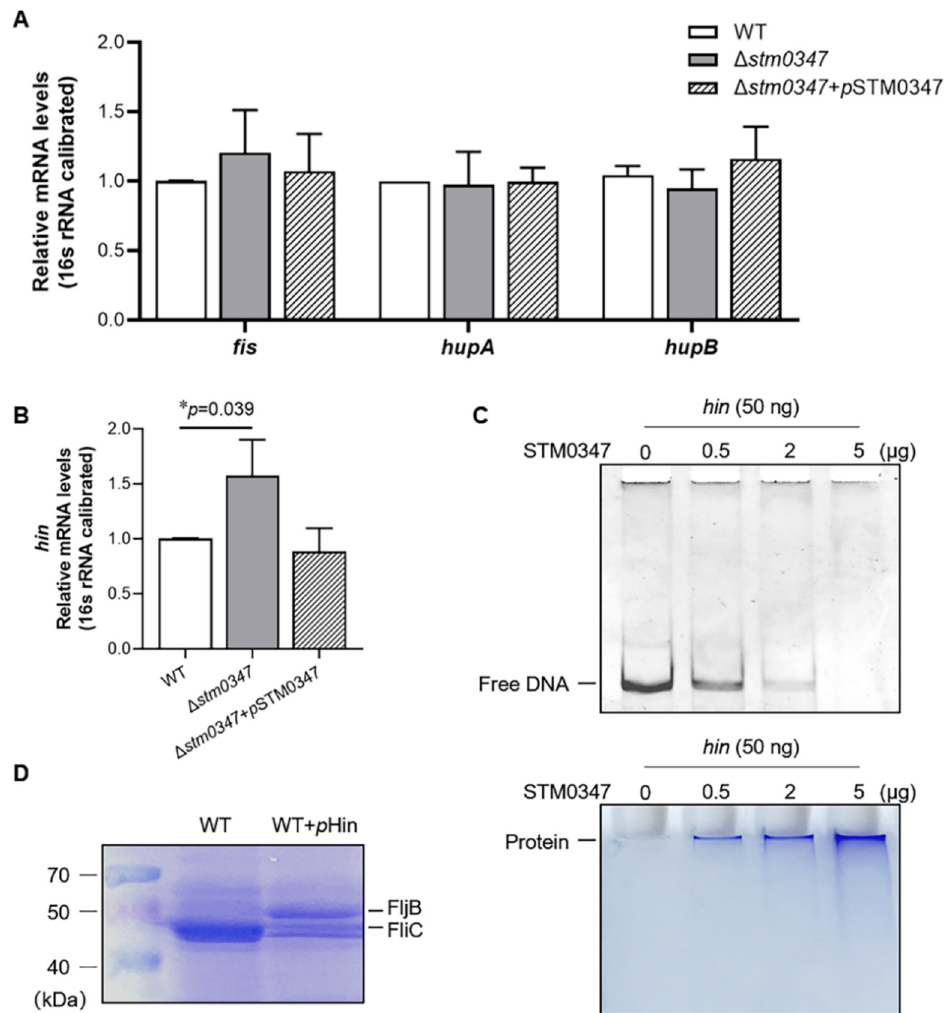
Figure 6. STM0347 inhibits Hin-catalyzed DNA reversion through diminishing hin level. ( A ) Relative mRNA levels of fis , hupA , and hupB in WT, ∆ stm0347 , and ∆ stm0347 complemented with a STM0347-expressing plasmid induced with 0.001% arabinose. Expression levels are calibrated with 16s rRNA. Results are presented as mean ± SD. ( B ) Relative mRNA levels of hin in WT, ∆ stm0347 , and ∆ stm0347 complemented with a STM0347-expressing plasmid induced with 0.001% arabinose. Expression levels are calibrated with 16s rRNA. Results are presented as mean ± SD. Asterisks indicate significant differences (* p < 0.05). ( C ) In vitro incubation of STM0347 and hin DNA segment. Different amounts of purified STM0347 (ranging from 0 to 5 µ g) were incubated with hin DNA segment prior to electrophoretic separation. ‘Free’ indicates undegraded DNA bands. Gels were stained with Goldview (up) or Coomassie blue (down). ( D ) Secreted proteins in WT, and WT complemented with a Hin- expressing plasmid induced with 0.2% arabinose, were visualized with Coomassie